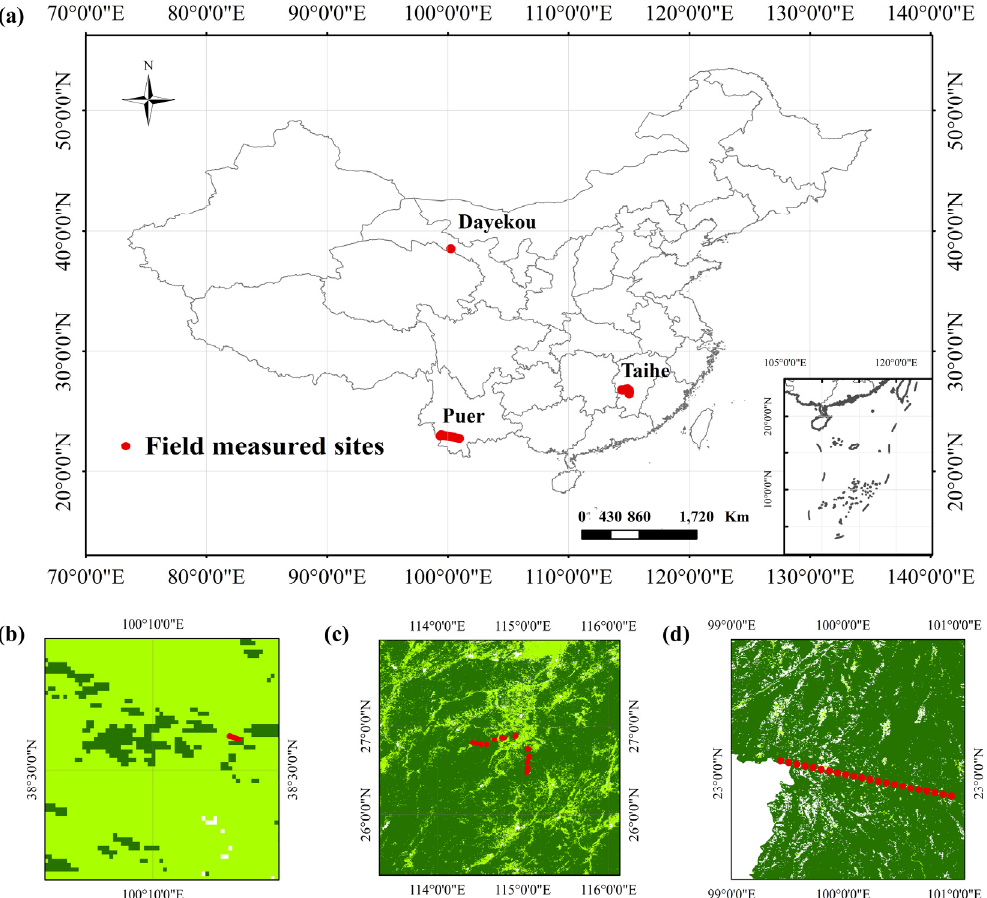
Figure 1. Field measurement sites. ( a ) Distribution of three field measurement regions; ( b ) Dayekou field sites in Gansu; ( c ) Taihe field sites in Jiangxi; ( d ) Puer field sites in Yunnan; ( b – d ) the background color map represents the MODIS land cover (LC) forest